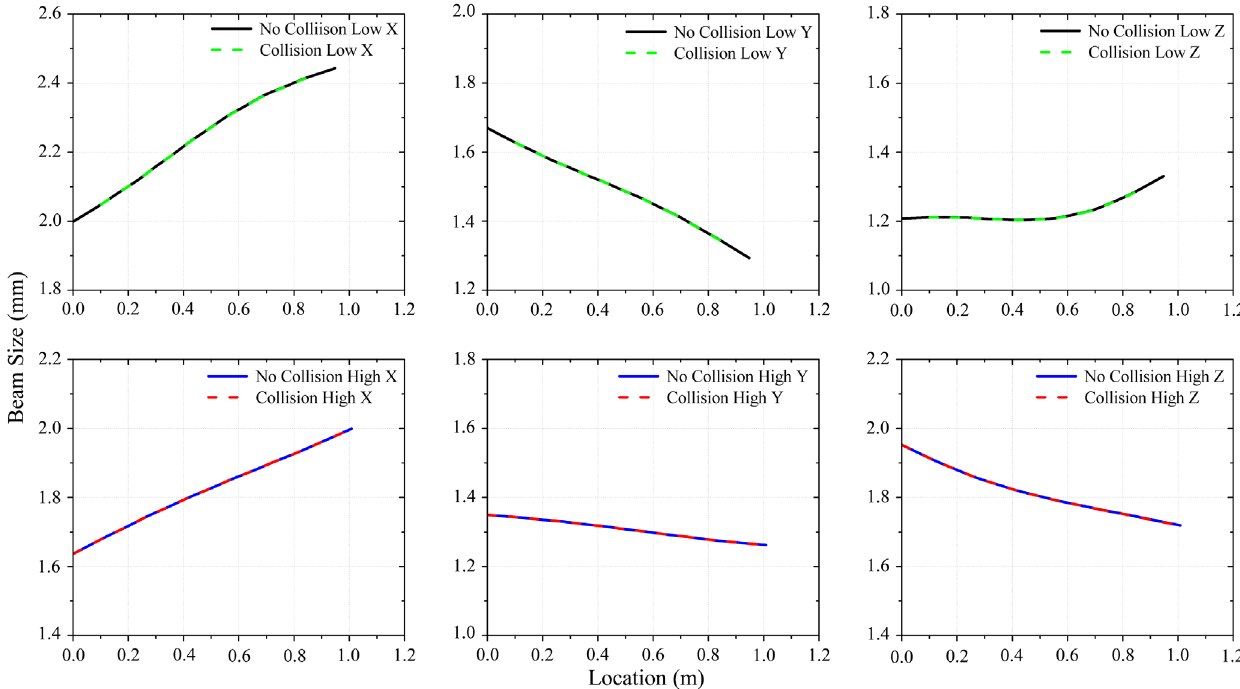
FIG. 5. The rms size evolution of the single-bunch simulation and the combined two -bunch simulation in the first cavity collision